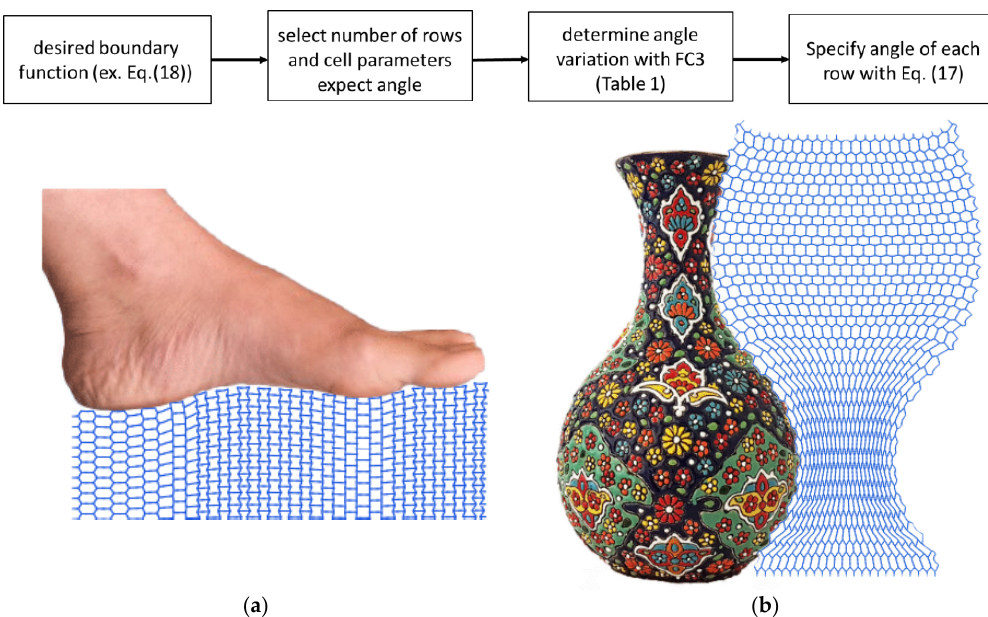
Figure 9. A flowchart is shown in the top row showing the steps necessary for the design of mechanical metamaterials. This flowchart was used to back-calculate the microarchitecture of lattice structures for predicting the complex 1D shapes of two arbitrary examples, namely foot ( a ) and vase ( b ). Based on the elasticity approach proposed here, the microarchitectures of the lattice can be determined using re-entrant unit cells.